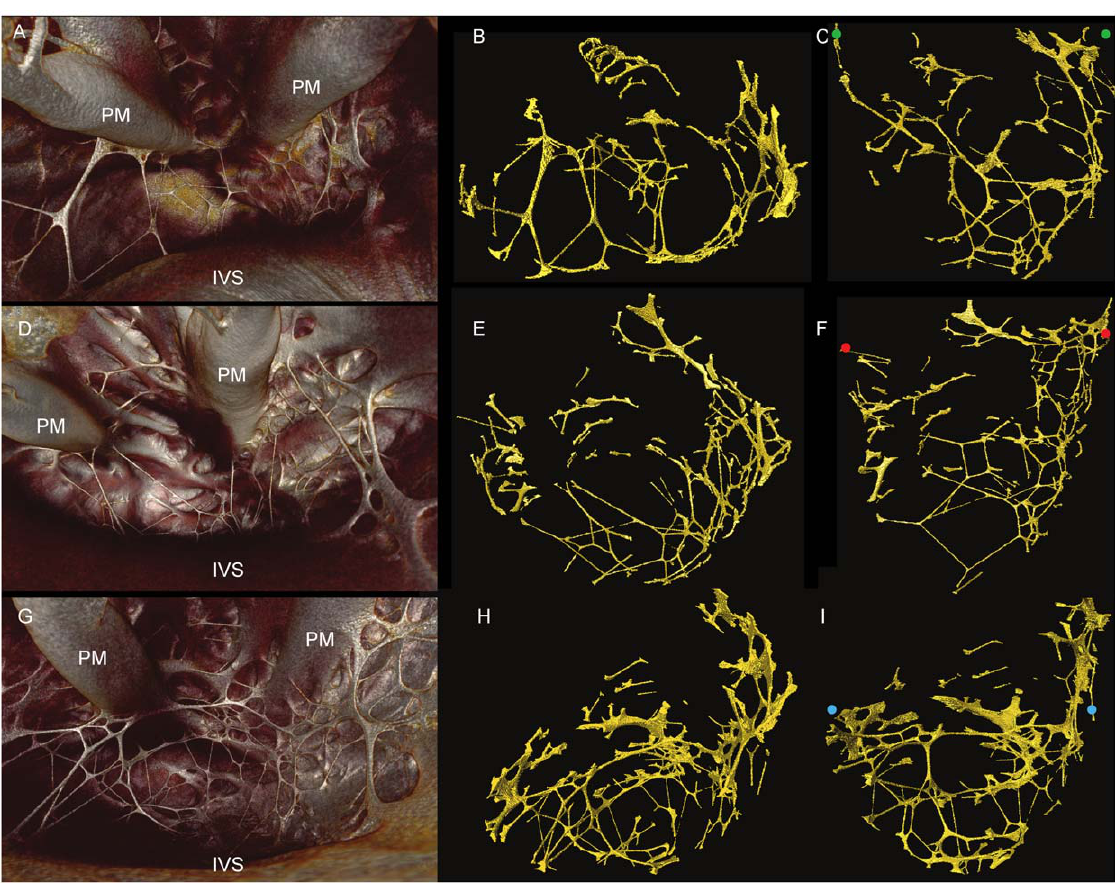
Figure 9. Comparison of existing and current models of the sino atrial node. Existing model of the SAN in rabbit (modified from Dobrzynski et al. 2005) constructed from immunohistochemically stained sections (A,C), superimposed onto a schematic representation of the heart showing the SAN epicardial position (A), and its relationship with the myocardium on the endocardial surface (C). Volume rendering of the current model in rabbit of the SAN, showing its true position on the epicardial (B) and endocardial (D) surfaces. Ao- Aorta, CS- coronary sinus, IVC- inferior vena cava, PA- pulmonary artery, PM- pectinate muscle, PV- pulmonary veins, RA- right atrium, SAN- sinoatrial node, SANP- sinoatrial node periphery, SVC- superior vena cava.